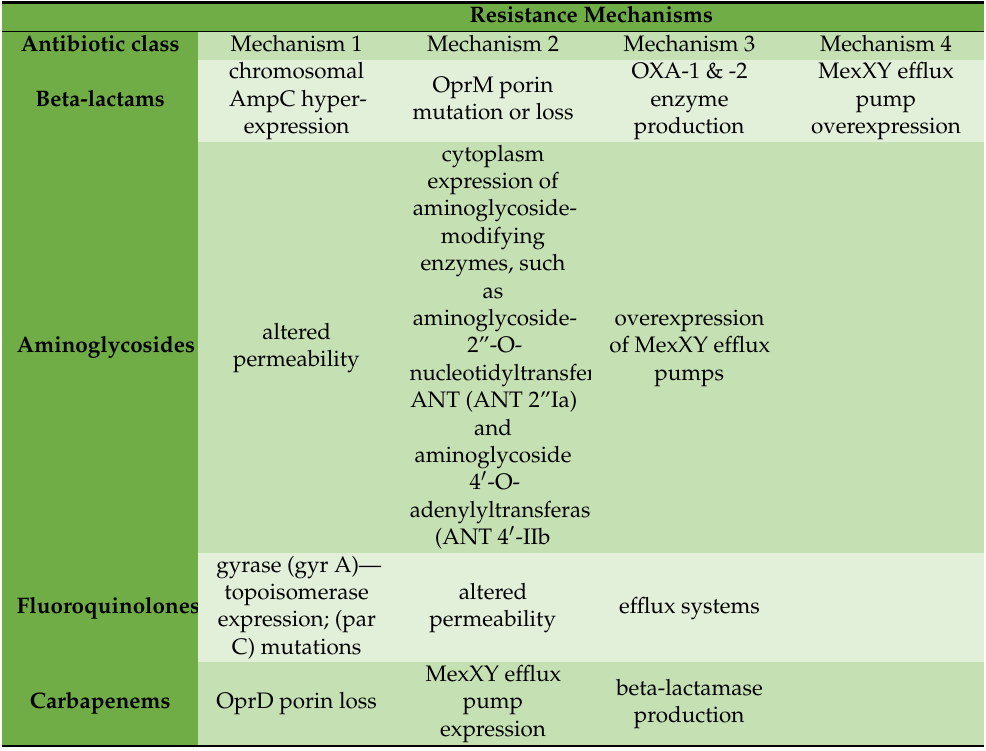
Table 3. Major resistance mechanism of P. aeruginosa based on antibiotics